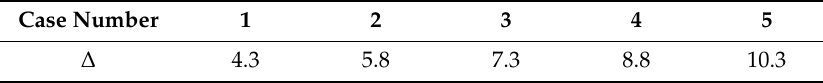
Table 3. Di ff erent cases and their corresponding ∆